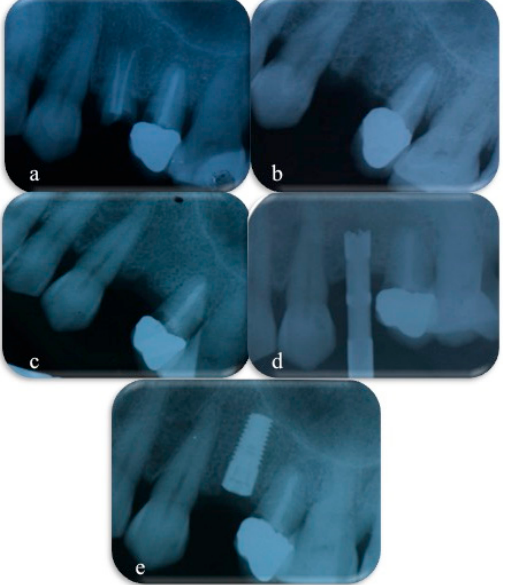
Figure 3. X-rays collected before tooth extraction ( a ), immediately after tooth extraction and socket preservation procedures ( b ), after 4 months of healing ( c ), during bone sample collecting with a trephine bur ( d ), immediately after implant placement ( e ).